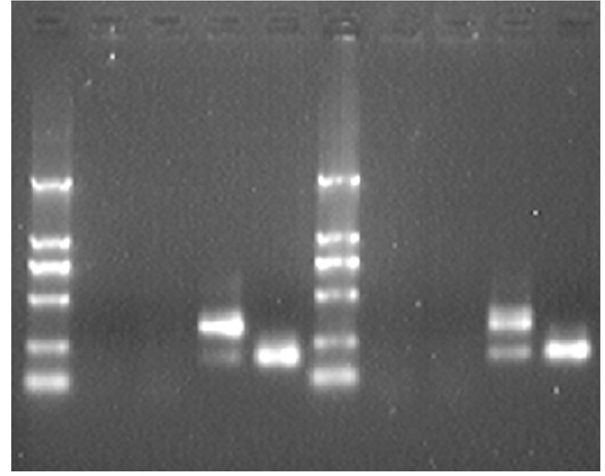
Figure 4. PCR products of DSPP alleles in splicing vector pLRT transfected into 293T and COS-1 cells. From left to right: D2000 marker, 293T cell control, naı¨ve pLRT, mutant DSPP allele and wild type DSPP allele in 293T cells, D2000 marker, COS-1 cell control, naı¨ve pLRT, mutant DSPP allele and wild type DSPP allele in COS-1 cells.